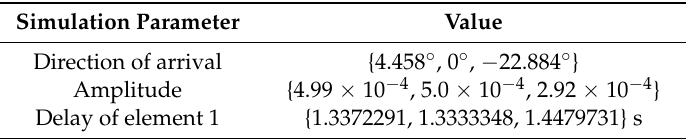
Table 3. Simulation parameters target at 0 ◦ .